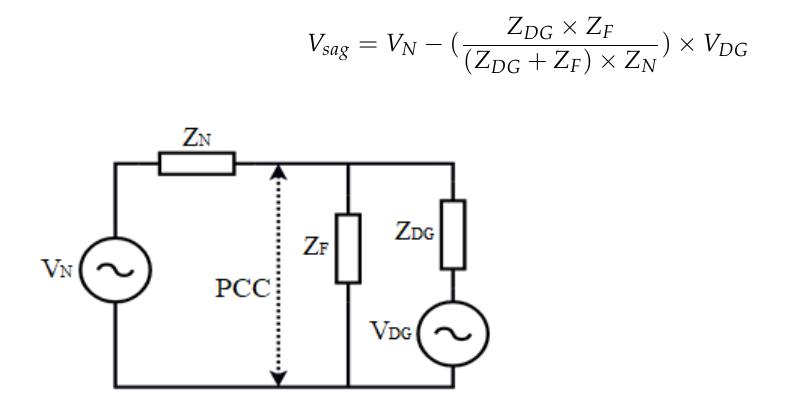
system in Figure 2, its equivalent per phase circuit is defined, as shown in Figure 3. (PCC) for symmetrical faults is calculated using Equation (1), with V N , V DG , Z N , Z DG the fault impedance.